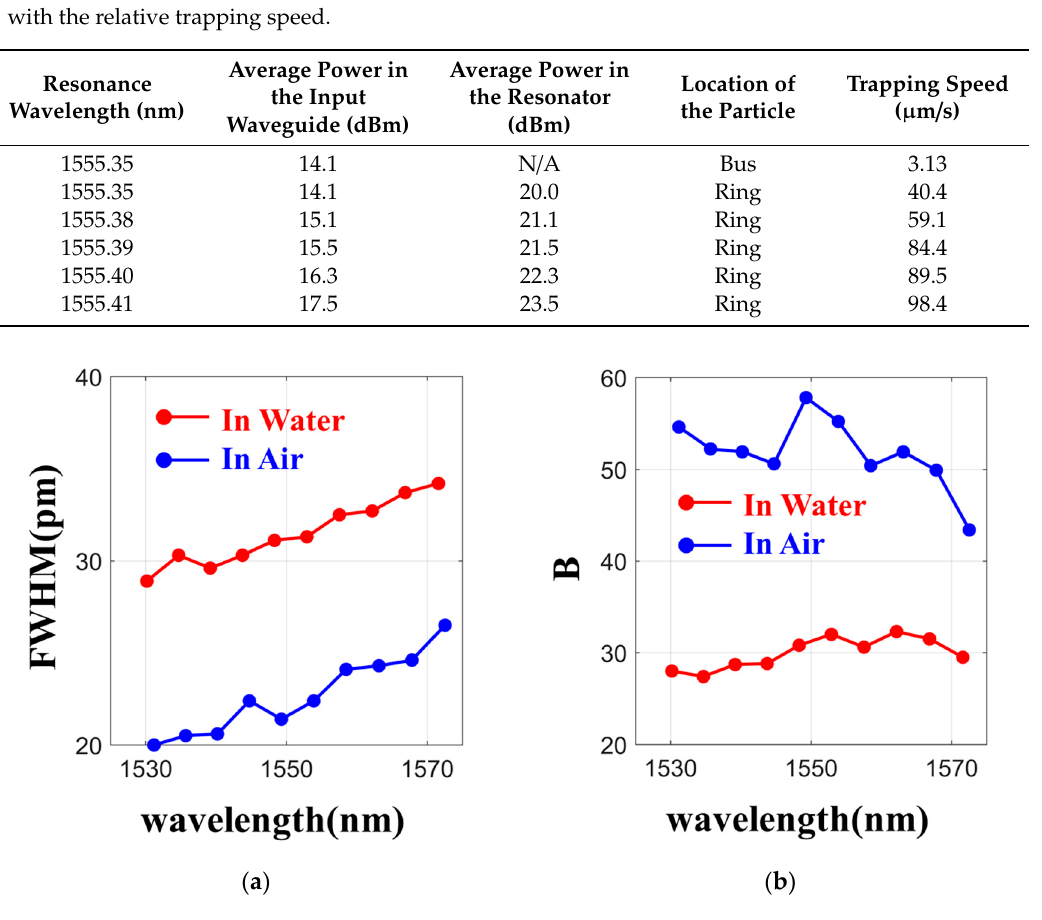
Figure 7. ( a ) The FWHM in different wavelengths in air and water. ( b ) The confinement factor (B) in different wavelengths in air and in water.